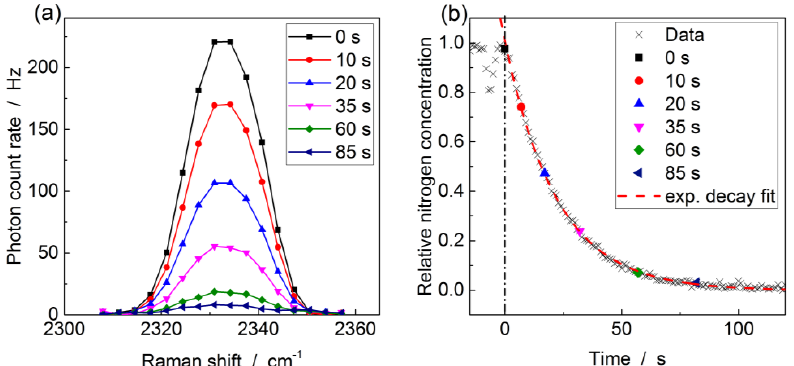
Figure 4. Procedure for evaluating the total nitrogen Raman scattering rate, illustrated using a 0.8 m length of kagomé-PCF at an absolute input pressure of 2 bar. ( a ) Nitrogen peak around 2331 cm −1 at various times during the gas exchange; ( b ) Transient plot of the integrated Raman scattering rate during gas exchange, which starts at t = 0 s. An exponential fit yields the t 90 time. To determine the gas exchange times for different fiber lengths and input pressures, Raman spectra are recorded at a frequency of 1 Hz for the kagomé-PCF and 2 Hz for the PBG-PCF. The